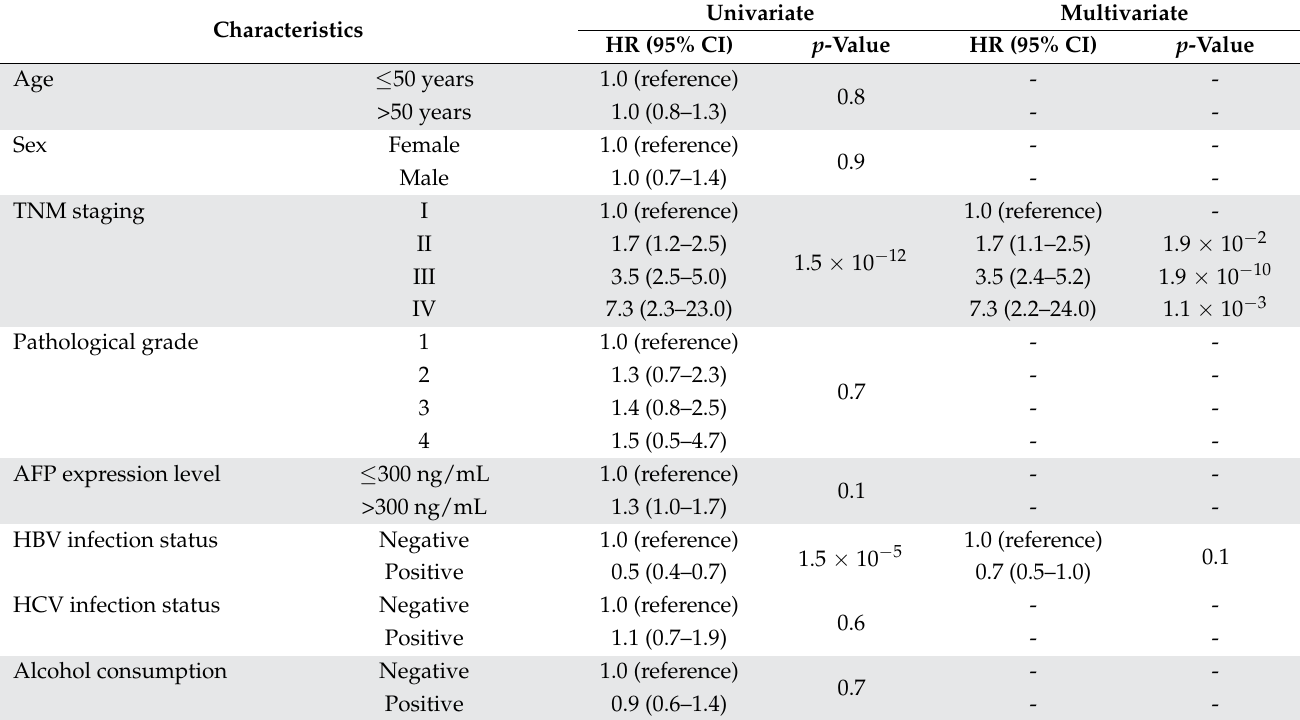
Table 4. Univariate and multivariate prognostic analyses for OS (n =